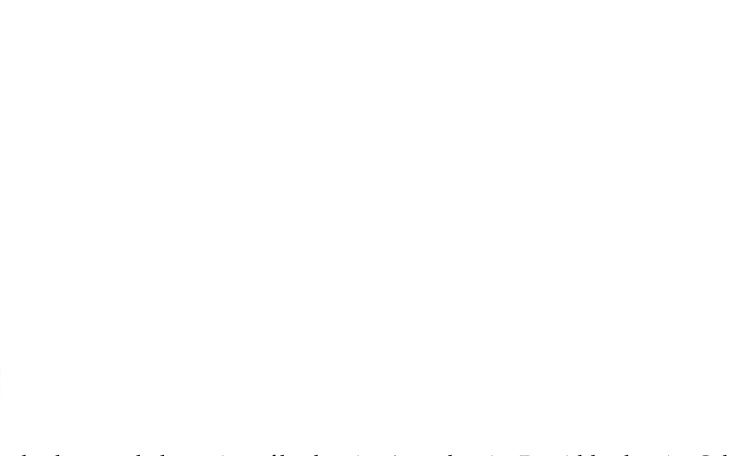
Figure 2. Drawing of the back to mark the region of back pain. A: neck pain, B: mid-back pain, C: low back pain.